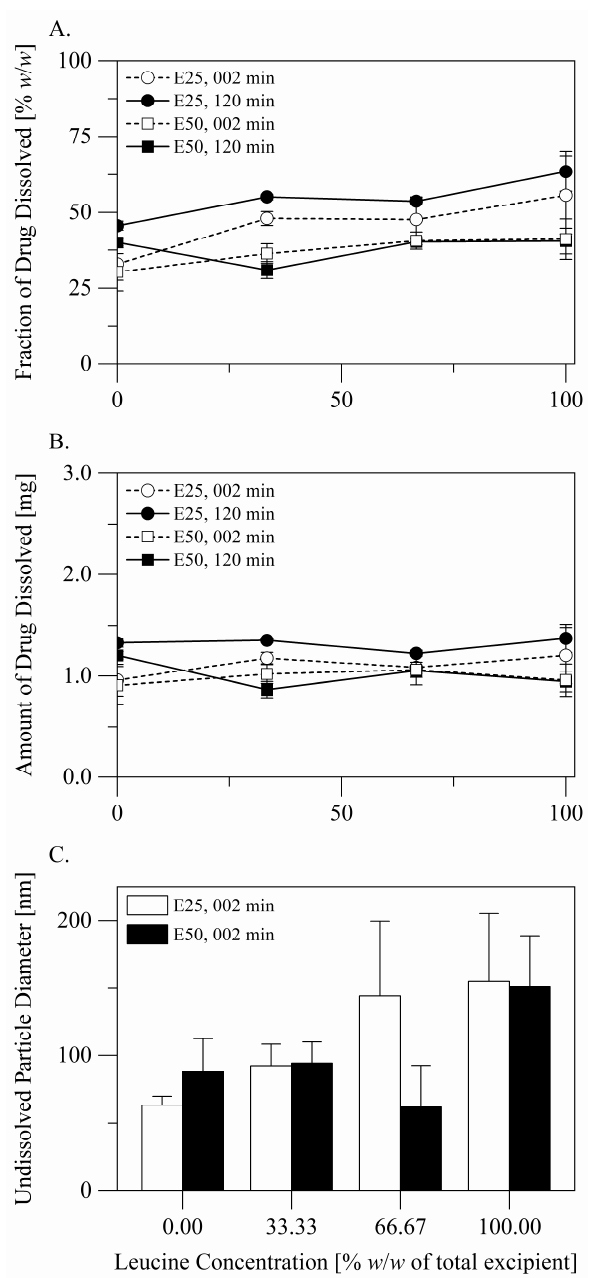
Figure 3. Disintegration and dissolution of the particles of the formulations: ( A ) the fraction of drug dissolved at 2 and at 120 min, ( B ) the amount of drug dissolved at 2 and at 120 min, ( C ) the diameter of undissolved drug particles at 2 min.